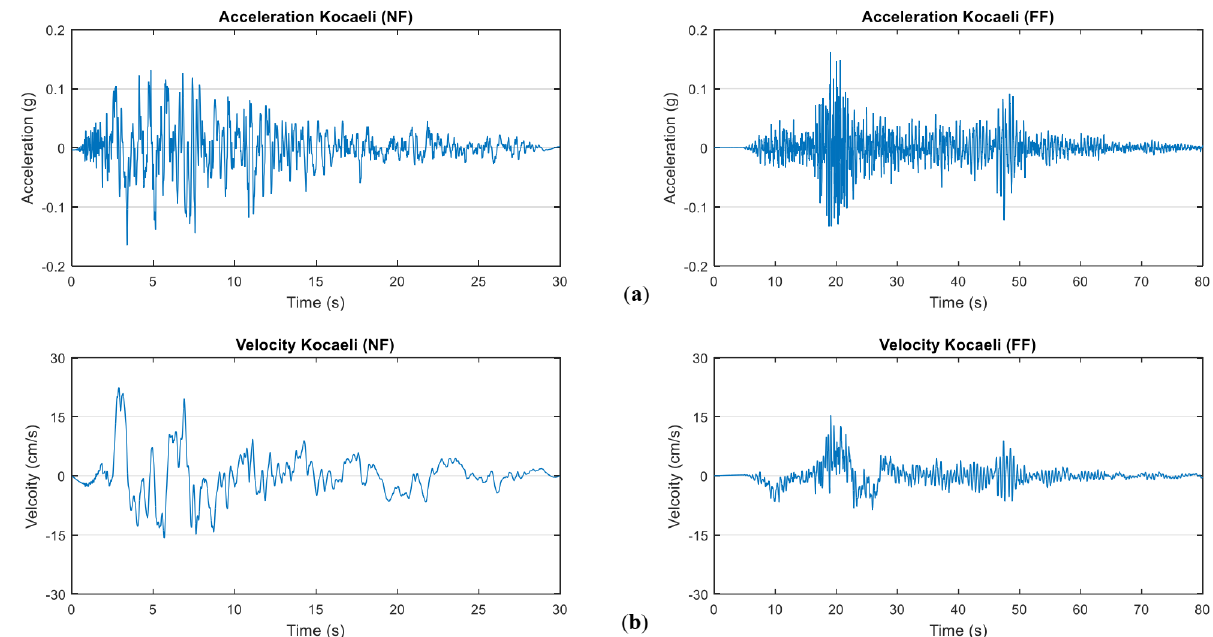
Figure 5. Near-fault and far-fault ground motions were recorded at the Kocaeli earthquake in 1999. ( a ) Acceleration time histories for near-fault and far-fault earthquake records. ( b ) Velocity time-histories for near-fault and far-fault earthquake records